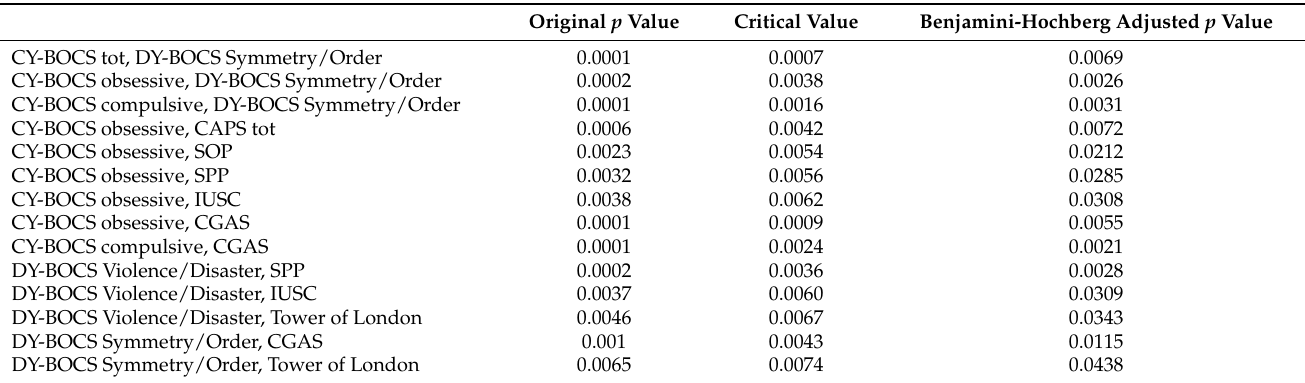
Table 3. False Discovery Rate results.